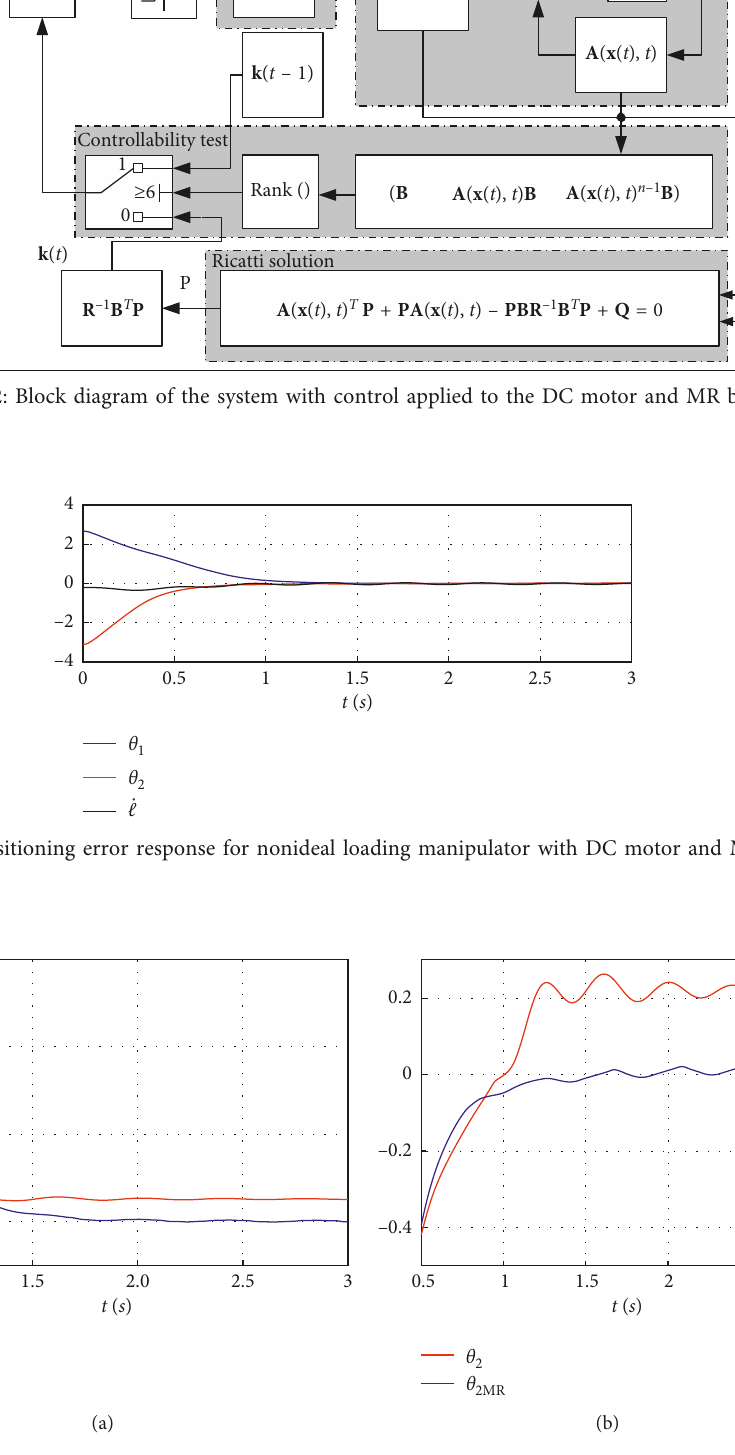
Figure 14: Comparison between the results of the manipulator with motor (in red) and MR coupling (in